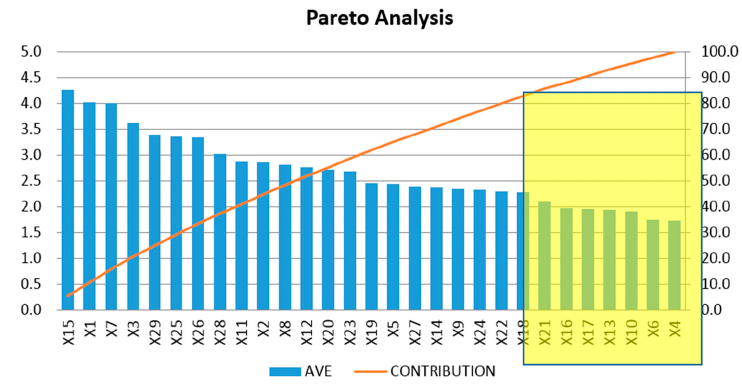
Figure 16. Pareto graph showing the 80–20 divide of the variables under study.